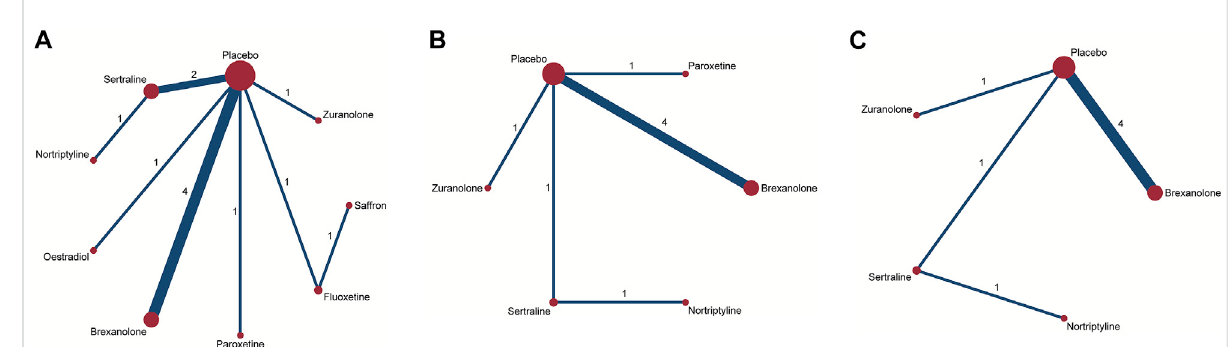
Network plots of treatment comparisons for the ef fi cacy outcomes. Circle size is proportional to the number of study participants assigned to receive each intervention. The line width corresponds to the number of studies comparing the treatments. (A) Change in SMD from baseline; (B) remission rate; and (C) responder